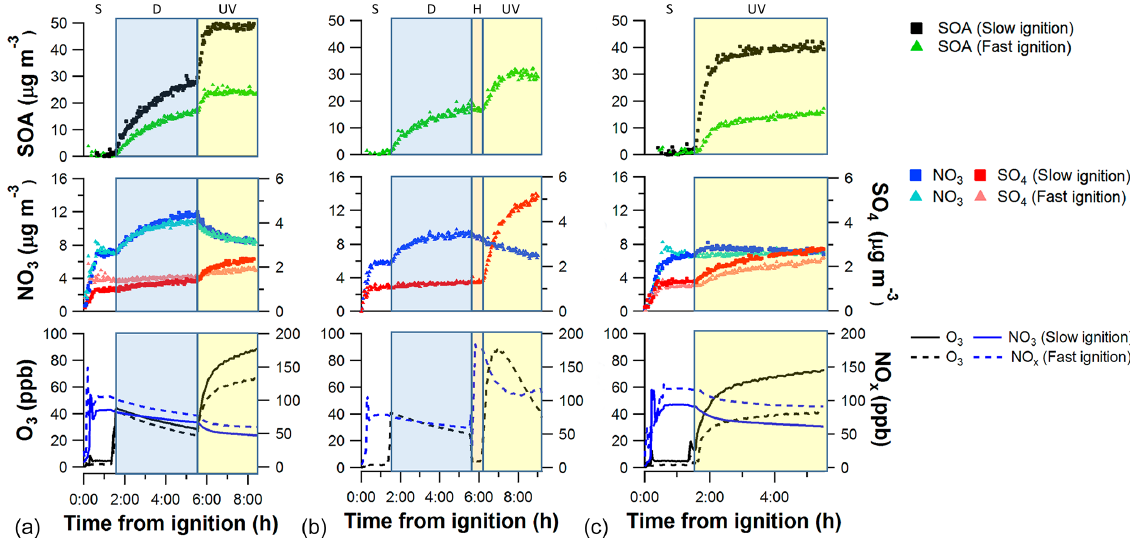
Figure 2. SOA mass and selected trace gas concentrations in a smog chamber for experiments (a) 1B and 2B, (b) 3B, and (c) 4B and 5B. Stabilization (40min) followed by filling the chamber (35min) is marked as S, dark aging as D, HONO addition as H and UV aging as UV. NO x /5 and O 3 /7 after the HONO addition is shown in Fig 2b. The SO 4 mass increase in Fig. 2b was mainly an artefact caused by SO 2 which ended up in the chamber together with the HONO addition. Table 5. Overview of the OA elemental analysis at the end of each experimental stage (stabilization, dark aging and UV aging); dark aging results are shown in bold. Dark/UV aging